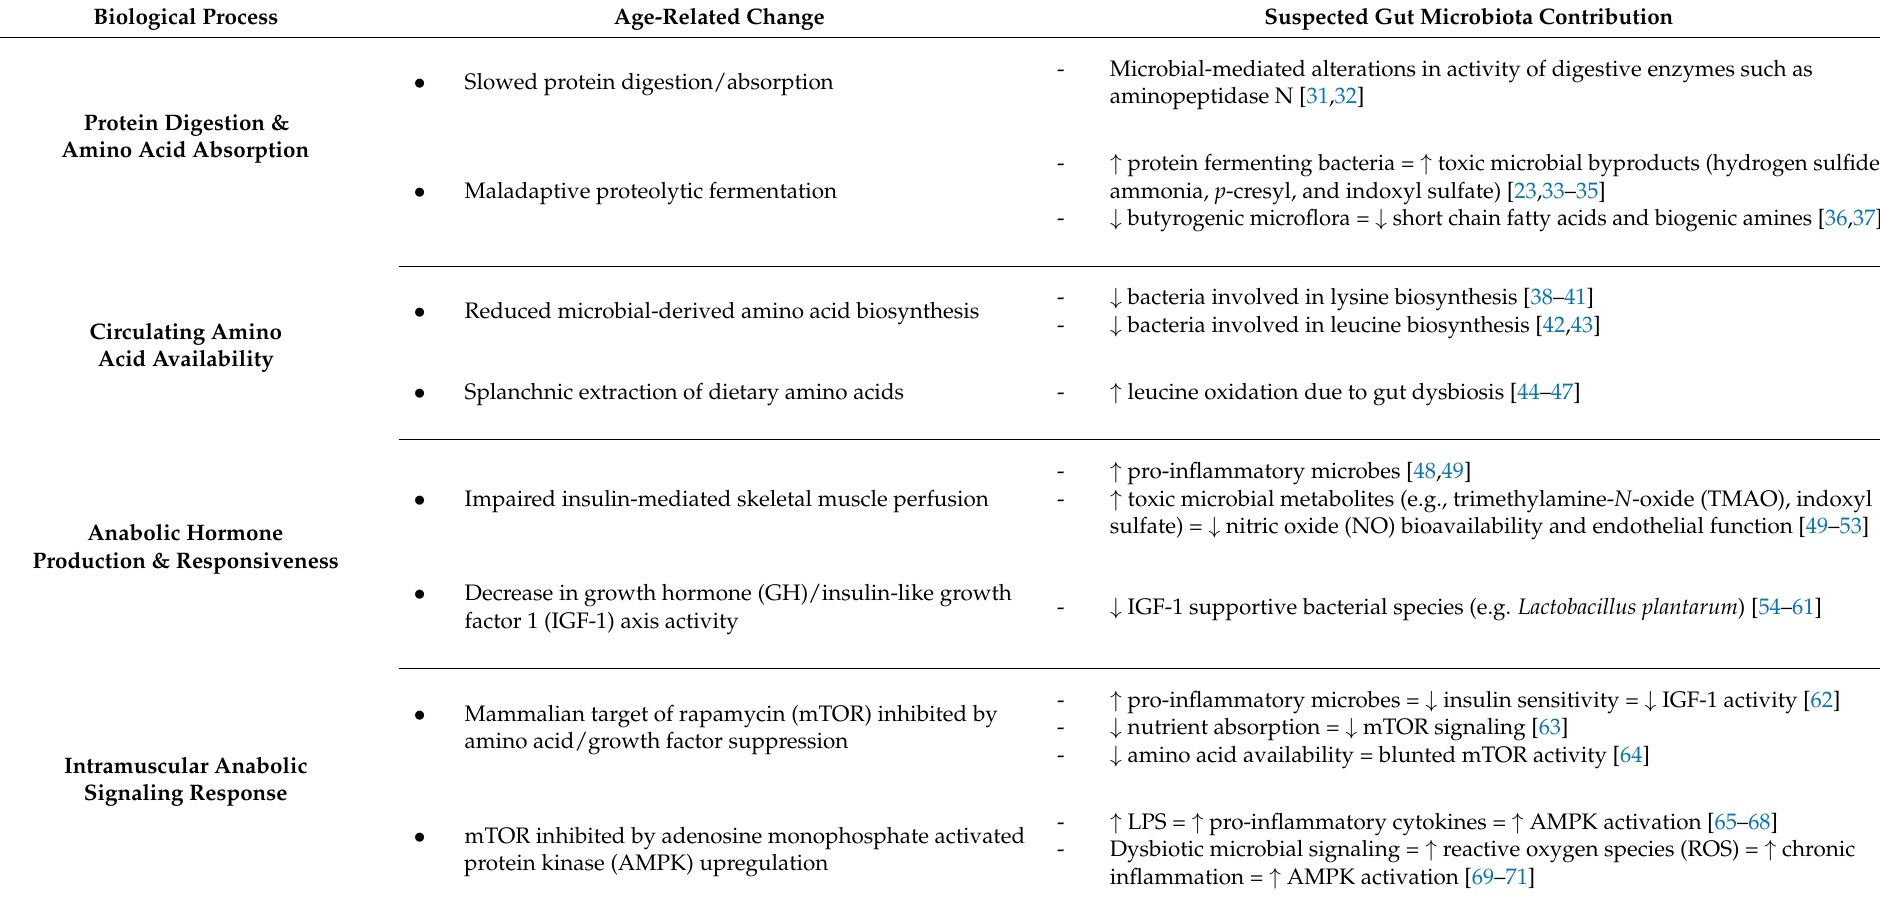
Table 1. The Aging Gut Microbiome & Anabolic